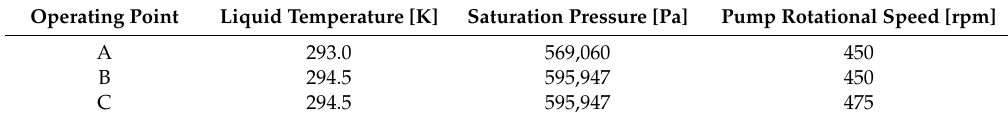
Table 1. Operating conditions of the ORC system.